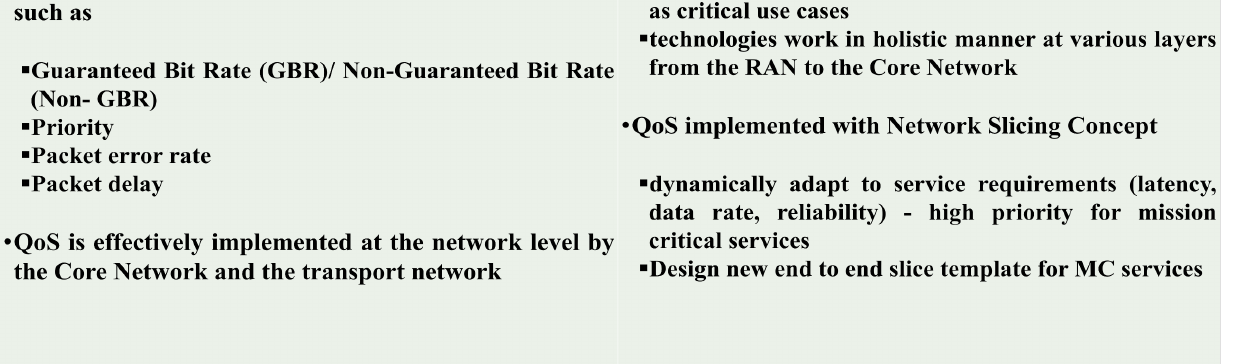
Figure 2. Comparative View of LTE and 5G